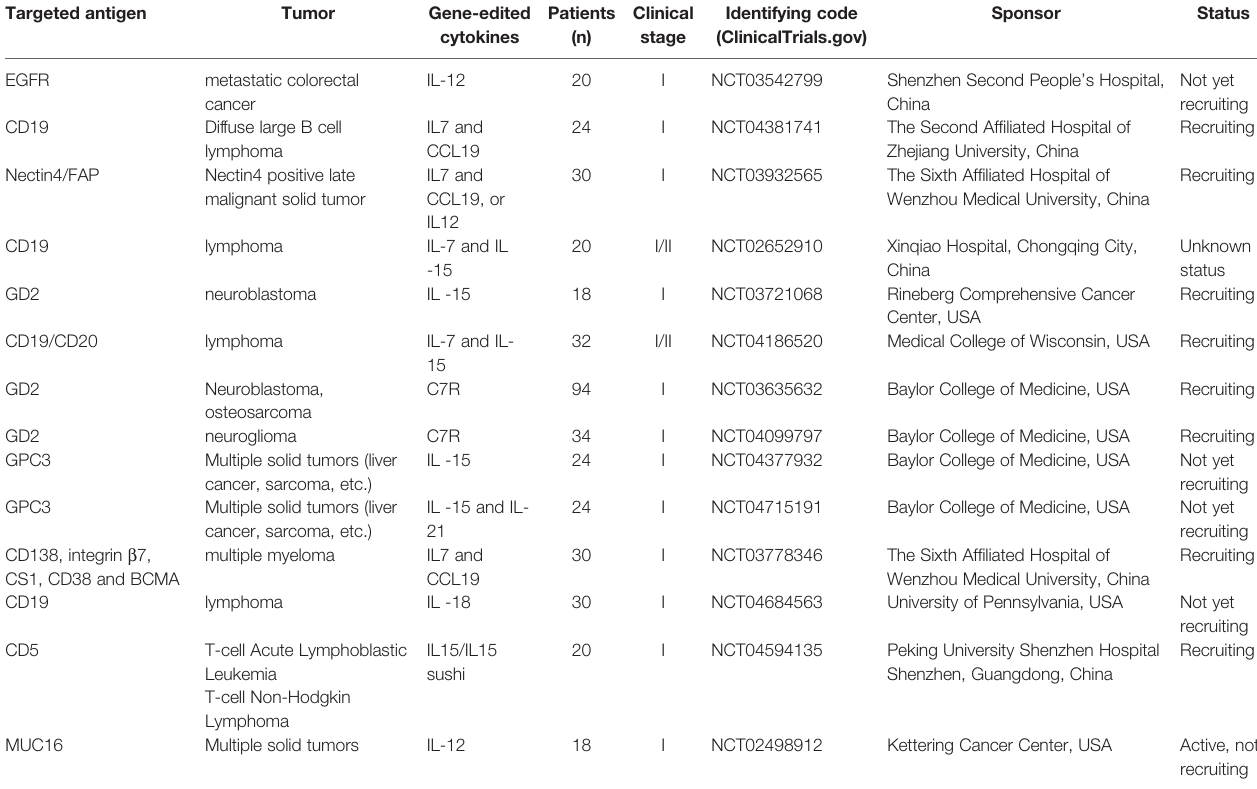
TABLE 3 | Clinical trial summary of gene-edited interleukin CAR-T cells. Targeted